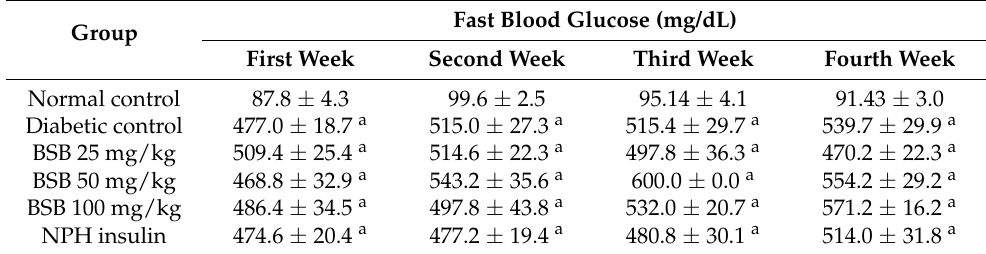
Table 2. Effect of bacuri seed butter on fasting blood glucose levels in STZ-induced diabetic rats after 4 weeks treatment.